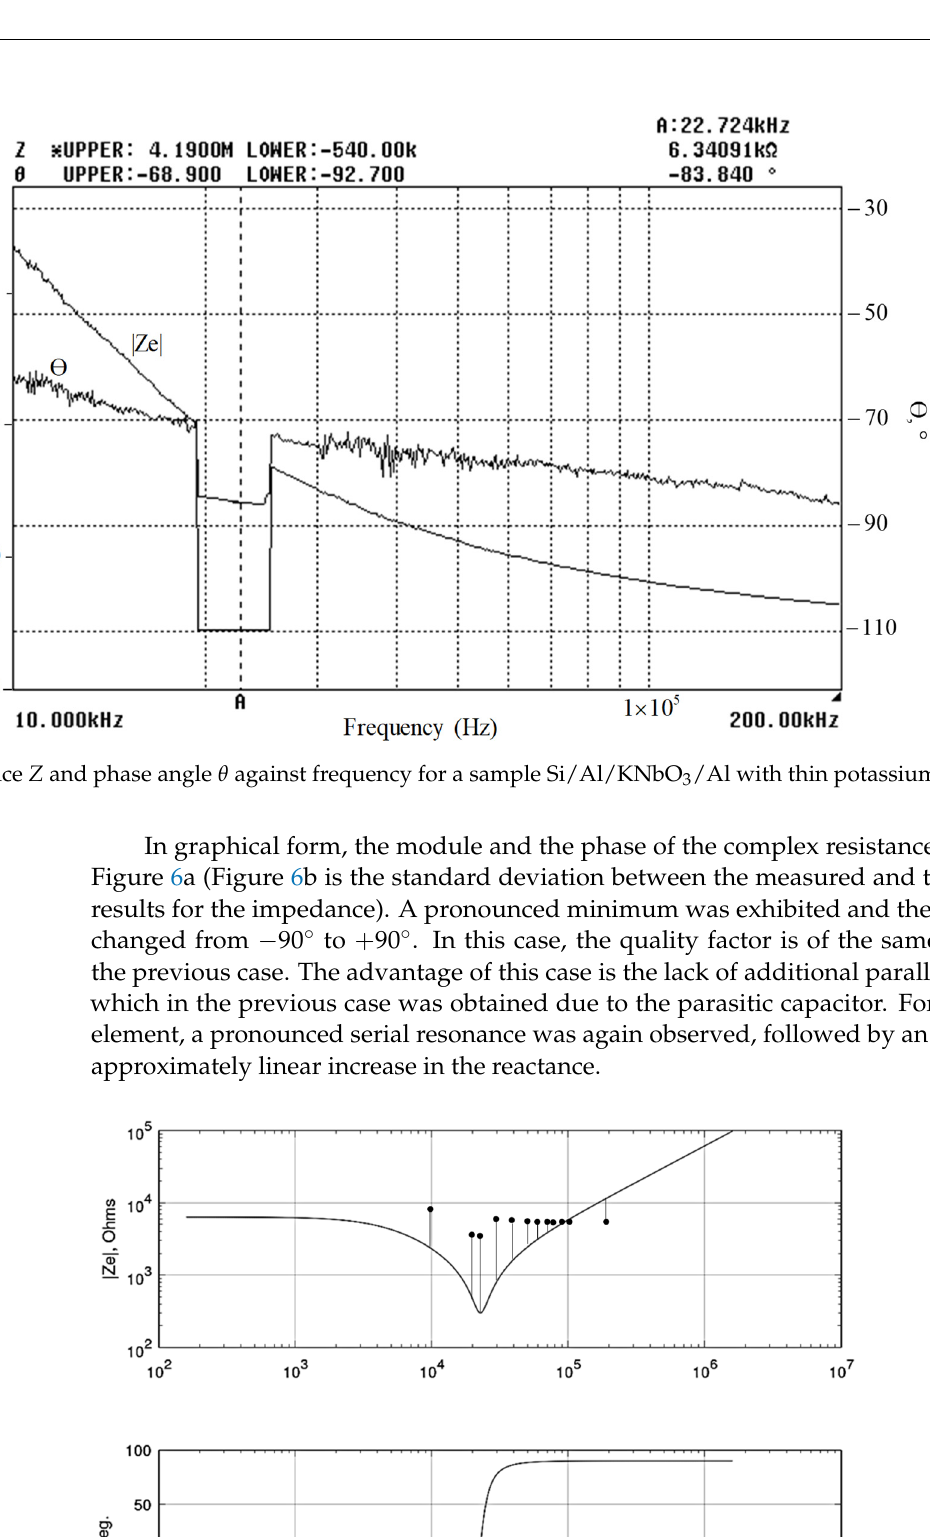
( b ) Figure 6. ( a ) Modelled characteristics of the module and the phase of the complex resistance for the equivalent circuit from Figure 2 for the case of KNbO 3 thinner film based piezoelectric trans- ducer; ( b ) standard deviation between experimental and modelled curves. Increasing the KNbO 3 film thickness to near 600 nm (thicker film), specific patterns of the impedance characteristics can be noted, which are actually overtone series around the main resonant frequency at 99.8 Hz (Figure 7a,b). Equivalent electrical circuit pre- sented in Figure 2 remained valid. It is known for thicker films that the piezoelectric phe- nomena are localized in the film bulk rather than distributed between the thin film and the substrate surface [31]. The mechanical waves propagate only in the piezoelectric ma- terial and the electrical processes are revealed there instead at the film/substrate interface. Thus, the dominant bulk behavior and the polycrystalline nature of the niobate sputtered films may be responsible for the overtones appearing. 20